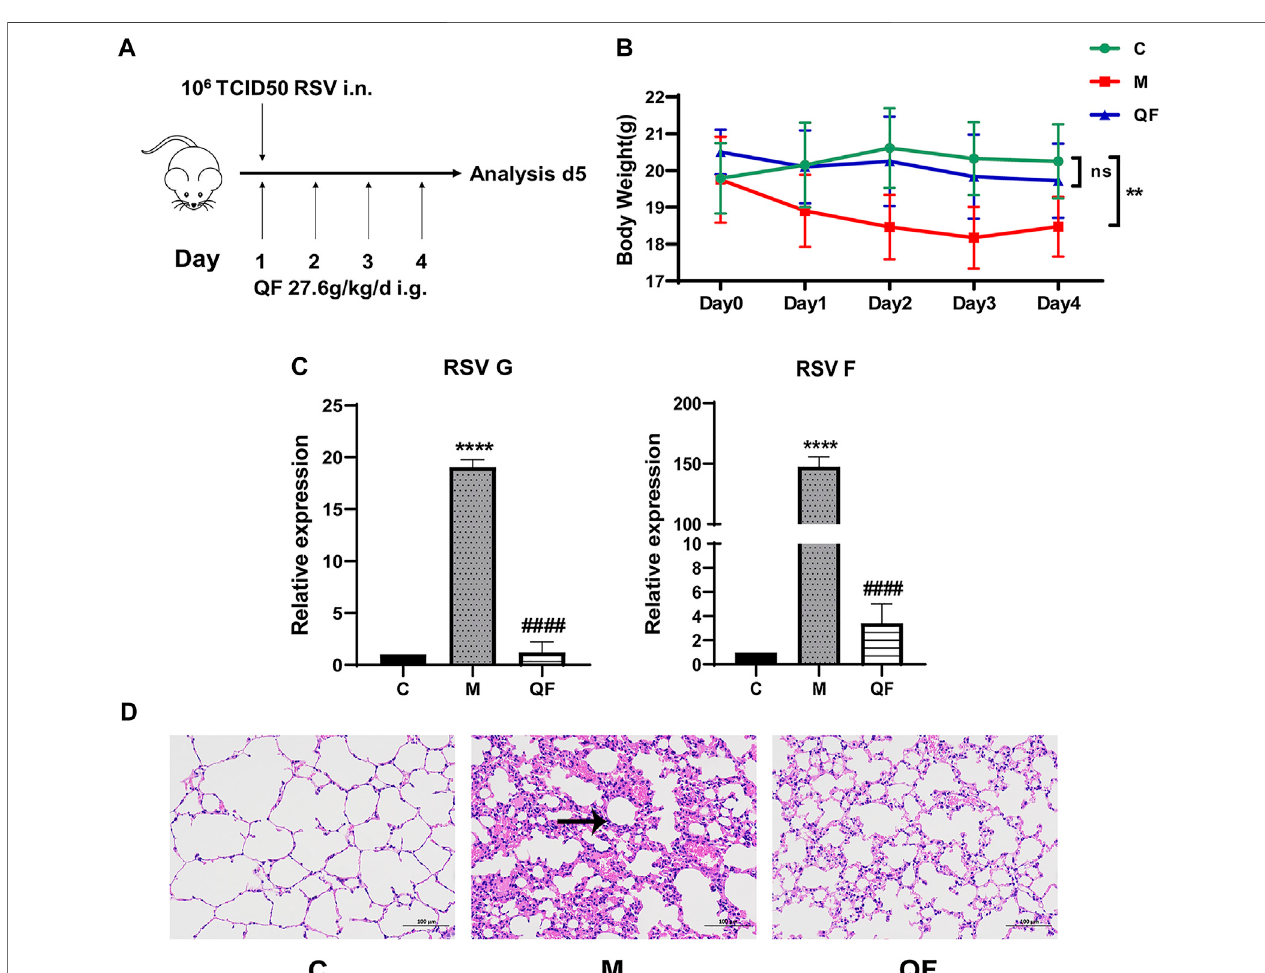
FIGURE 2 | Evaluation of RSV-induced lung in fl ammation mouse model and ef fi cacy of QF. (A) Schematic diagram of animal modeling and administration. (B) Weightchangesofmiceincontrol (C) ,model(M),andtherapy(QF)groupsfromday0today4.Valuesareexpressedasmean ± standarderrorofthemean(SEM;n (cid:1) 6,* compared with control group, ** p < 0.01, ns (cid:1) not signi fi cant). (C) Transcription levels of RSV F and RSV G proteins in lung tissues of mice in control (C), model (M), and therapy (QF) groups. Values are expressed as mean ± SEM (n (cid:1) 6, * compared with control group, # compared with model group, **** p < 0.0001, #### p < 0.0001. (D) H&E stainingtoevaluatepulmonaryhistopathologicaldamage incontrol(C),model (M), and therapy (QF)groups (200 × magni fi cation). Theblack arrow indicated the evident in fl ammatory cell in fi ltration in lung tissue. Abbreviations: QF, Qingfei oral liquid; RSV, respiratory syncytial virus.